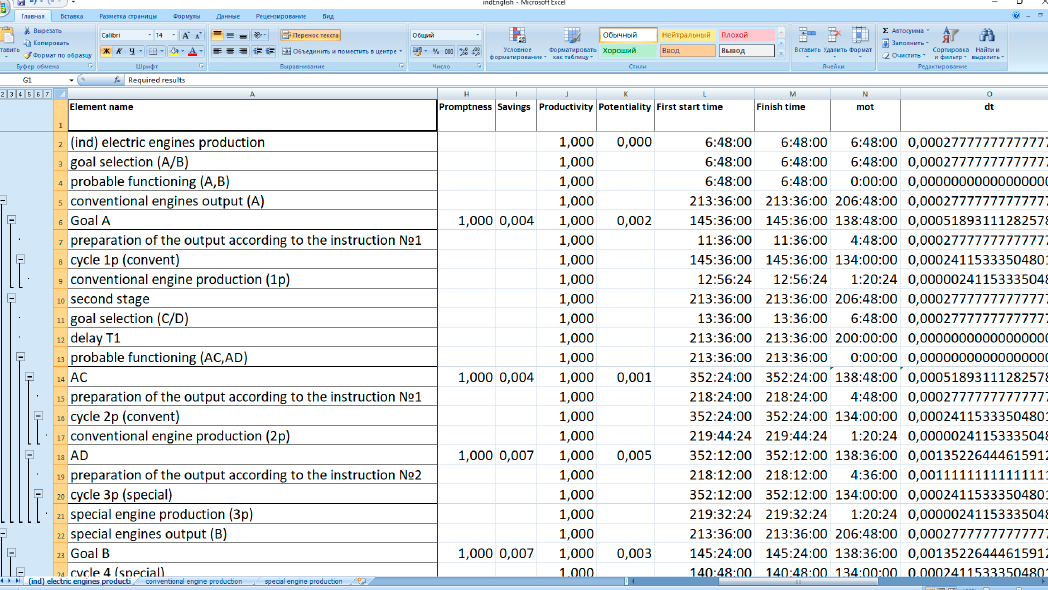
corresponding IT usage and dynamic capability indicators. IT usage and dynamic capability